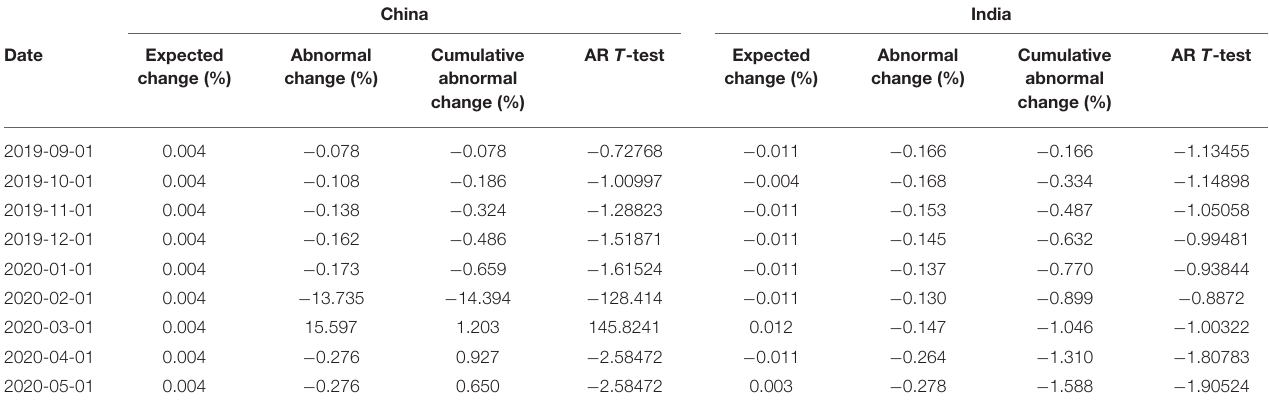
TABLE 3 | Estimation window: China and